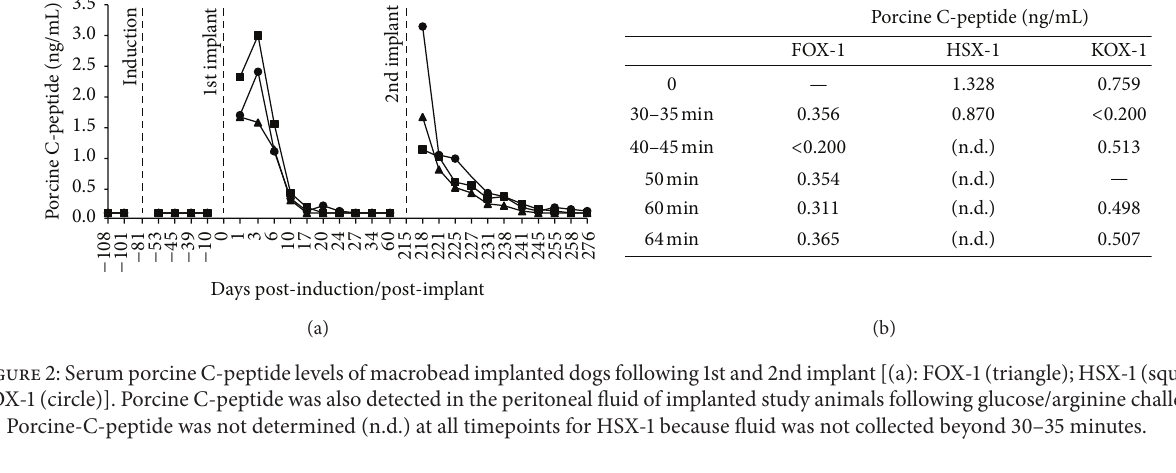
tissue. Peritoneal organs and tissues with a serosal surface